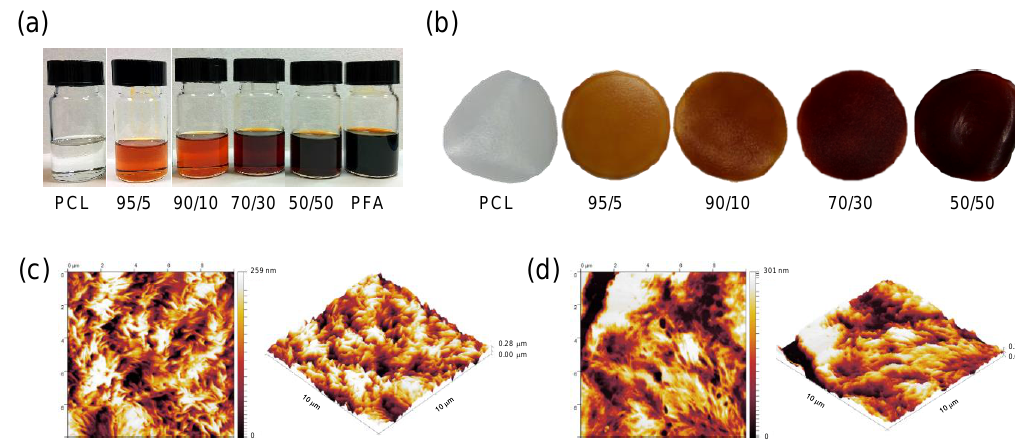
Figure 1. ( a ) Photographs of polymer solutions of polycaprolactone (PCL) and poly(furfuryl alcohol) (PFA) resin dissolved in dichloromethane (DCM) containing di ff erent PFA concentrations; ( b ) photographs of the blend films obtained after casting the solutions and drying. The films have a thickness of approximately 100 µ m and a diameter of 3 cm. Atomic force microscopy (AFM) images and 3D rendering of ( c ) a PCL film and ( d ) a 50 / 50 blend film. The AFM images are 10 µ m × 10 µ m in size.